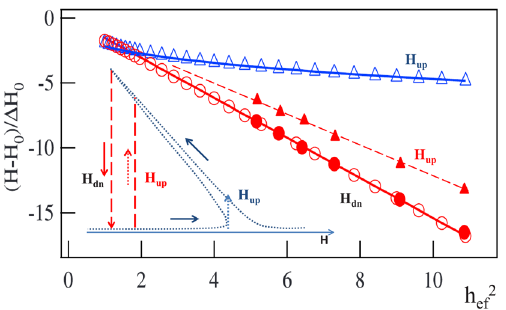
Figure 4. The dependence of fields H dn and H up in units of field shift divided by the line broadening ( (cid:31) H 0 ) as it described in 33 for a single oscillator and a microscopic sample (open symbols). We use this picture to show 2 the principal difference with our results. The parameter h ef is used, which is proportional to the pumping power as a fitting for field H dn (filled symbols). It is clearly seen that the field H up has a much larger shift from the resonance field than what follows from the theory of a single nonlinear